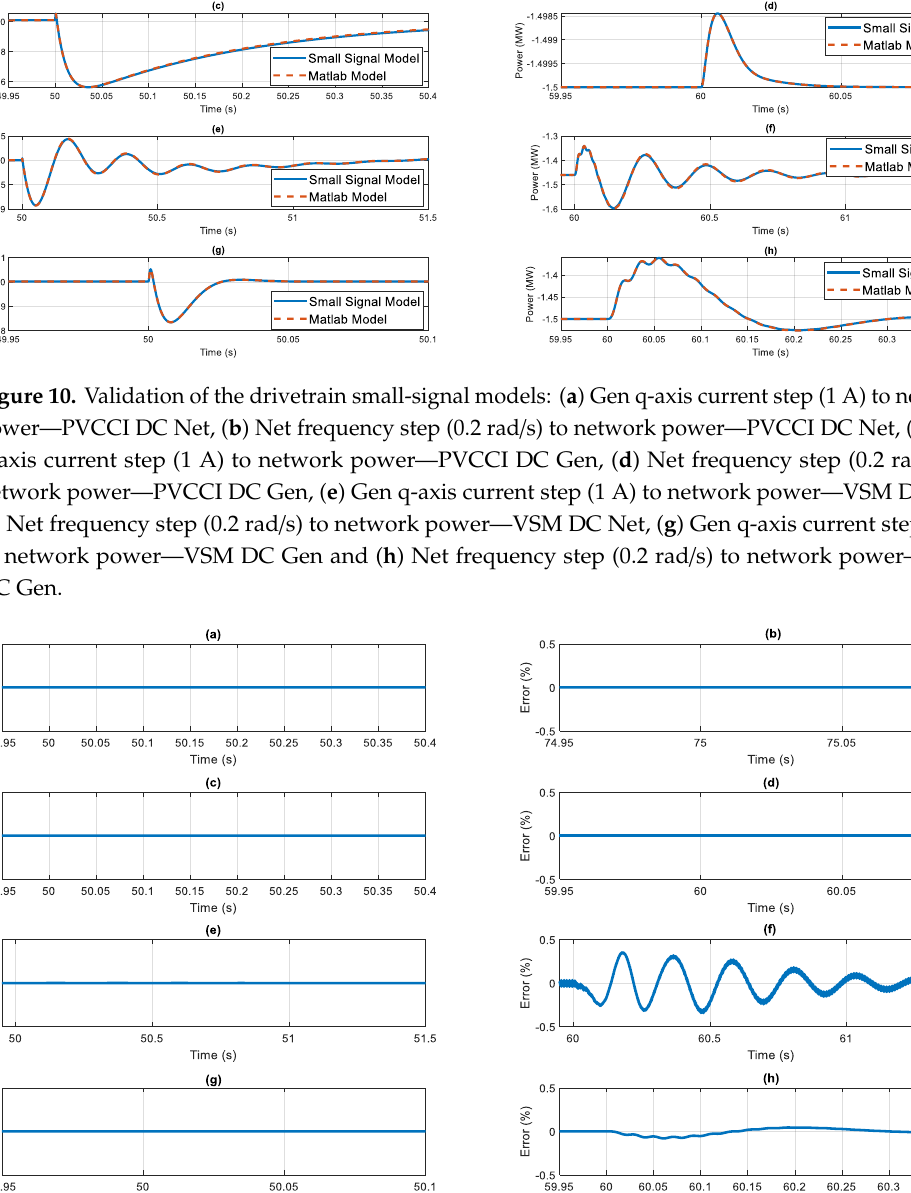
Figure 11. Validation of the drivetrain connected small-signal models: ( a ) Gen q-axis current step (1 A) to network power error for PVCCI DC Net, ( b ) Net frequency step (0.2 rad / s) to network power error for PVCCI DC Net, ( c ) Gen q-axis current step (1 A) to network power error for PVCCI DC Gen, ( d ) Net frequency step (0.2 rad / s) to network power error for PVCCI DC Gen, ( e ) Gen q-axis current step (1 A) to network power error for VSM DC Net, ( f ) Net frequency step (0.2 rad / s) to network power error for VSM DC Net, ( g ) Gen q-axis current step (1 A) to network power error for VSM DC Gen and ( h ) Net frequency step (0.2 rad / s) to network power error for VSM DC Gen.